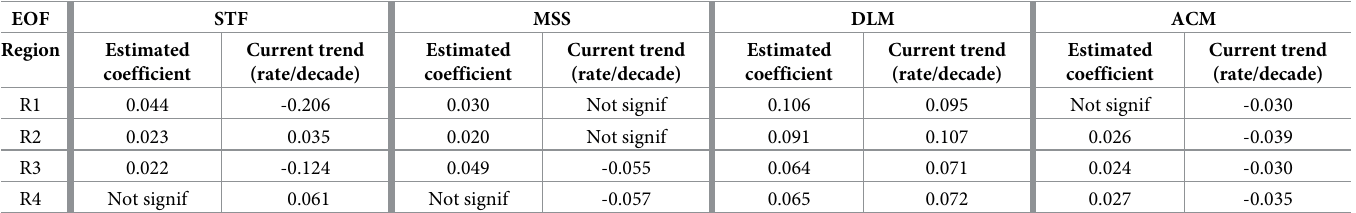
Table 6. Summary of the estimated coefficient for selected EOF modes in the LEOF models and the current temporal trend with its rate per decade for each region. Only modes with significant temporal changes are included. EOF